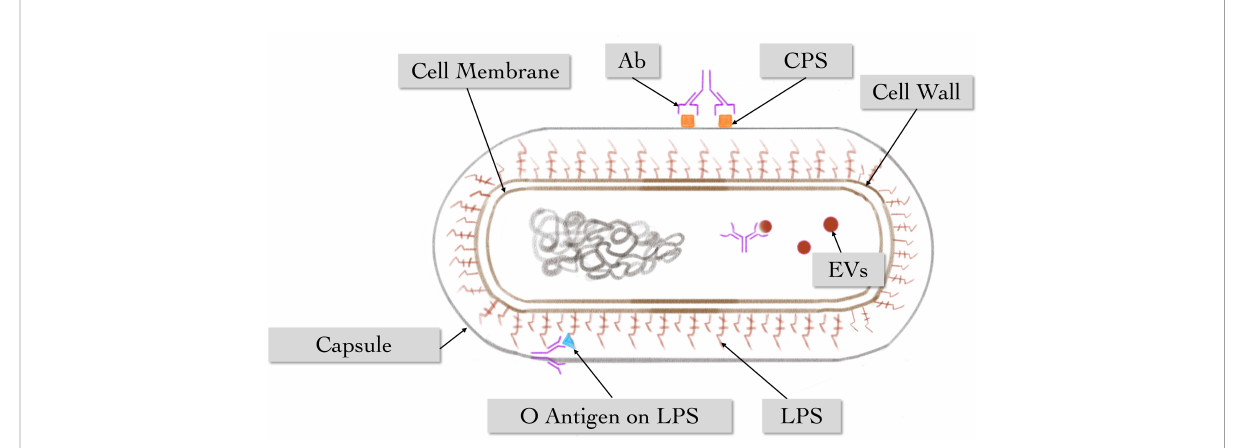
FIGURE 7 The main role of humoral immune response against K. pneumoniae . Multiple antibodies can act on different antigenic epitopes of K. pneumoniae , including vesicles, O-antigen on LPS, and antigen on